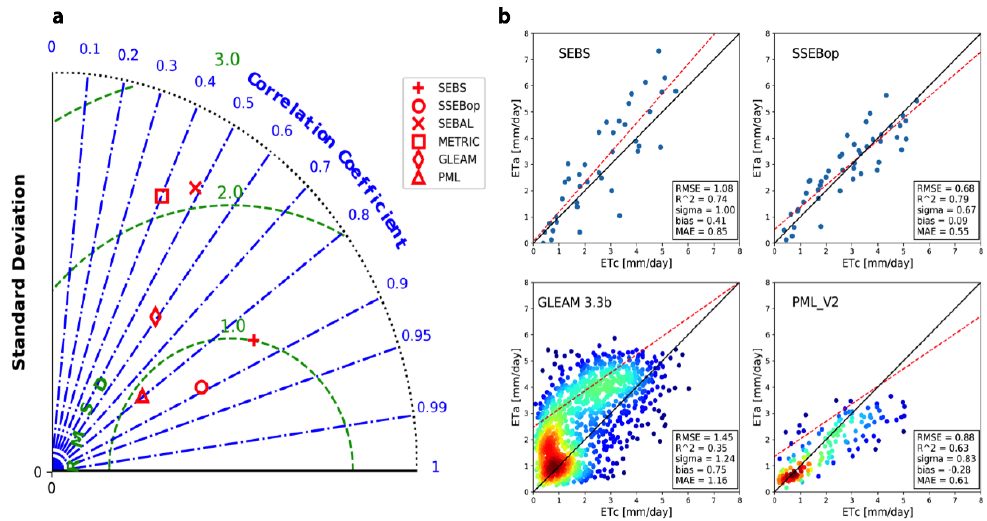
Figure 6. Performance of SEB models and global evapotranspiration products in Oromo. ( a ) Taylor diagram of evapotranspiration models in relation to the in-situ observations. The dashed green line denotes the root mean standard deviation (RMSD), while the dashed blue line indicates the correlation coefficient with the observations. ( b ) Scatterplots comparing estimated ( ET a ) and measured ( ET c ) evapotranspiration in Oromo. The worst performing models SEBAL and METRIC are not shown. The dashed red line represents the identity function, and the black line denoted the slope of the linear regression of each model. GLEAM and PML_V2 comparisons are shown as density scatterplots, with red and blue colors denoting high- and low-density areas, respectively.